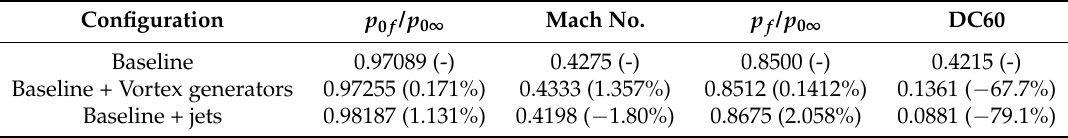
Table 5. Flow control predictions of the RAE-M2129 intake. USAFA grids were used with SARC-DDES turbulence model. CFD data are time-averaged from 2 to 2.5 s of simulation